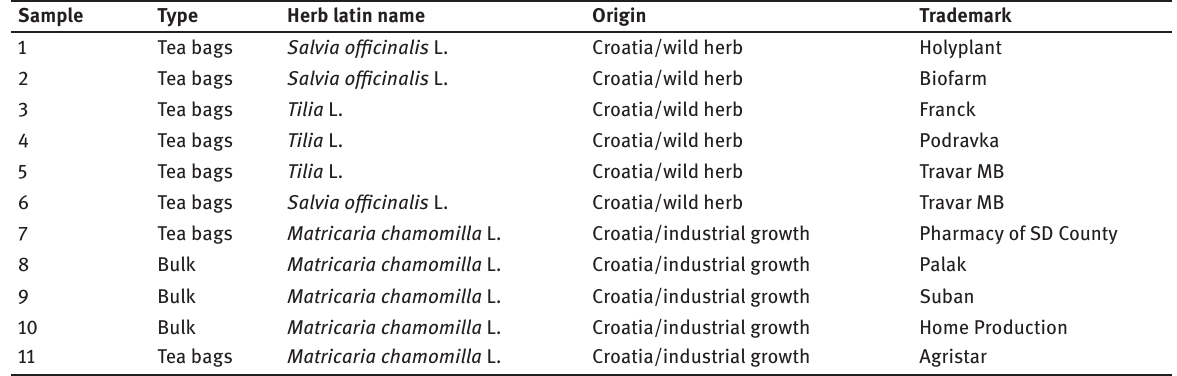
Table 3: Descriptions of investigated herbal tea